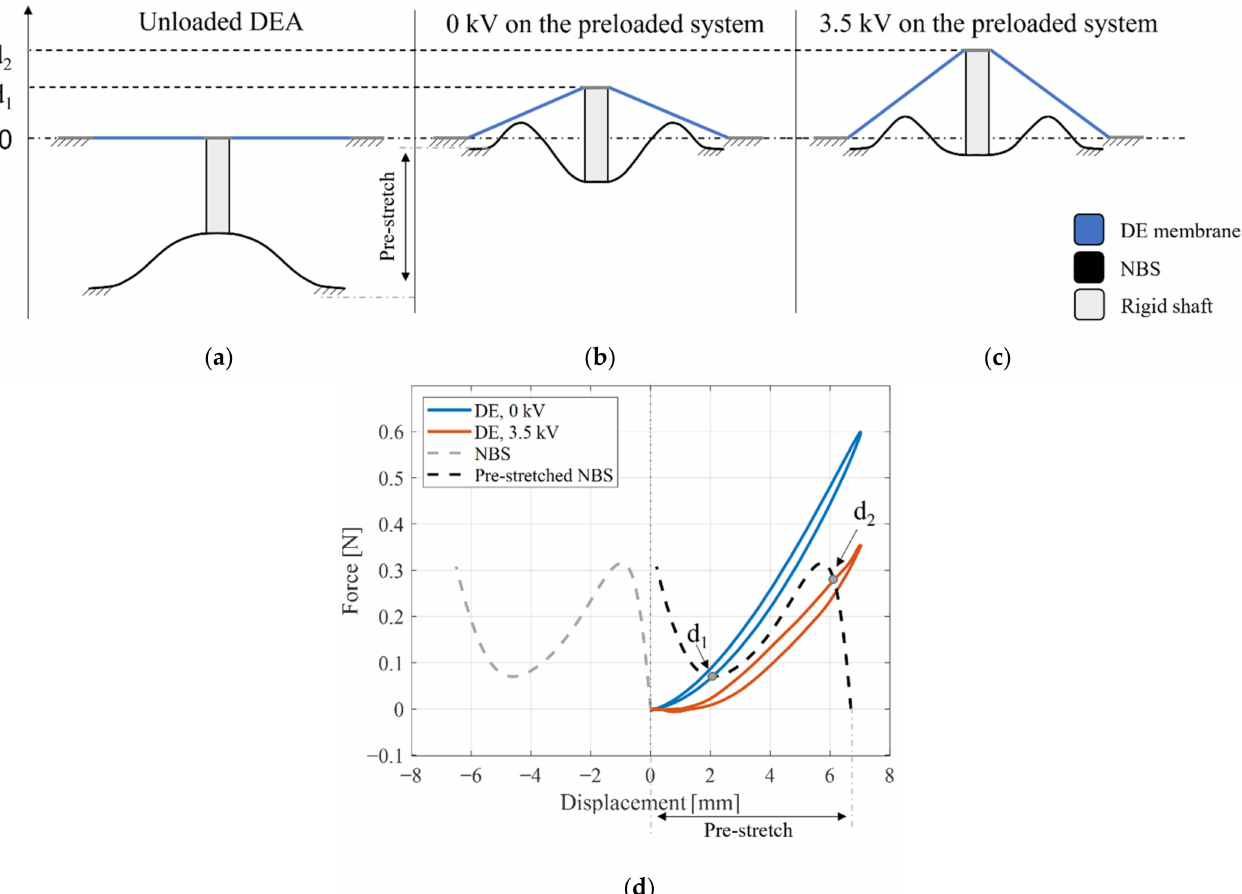
Figure 5. ( a – c ) Sketch of the DEA actuator composed by a DE membrane coupled with a NBS element, for three different configurations. ( d ) Actuator force equilibrium analysis, intersection points d 1 and d 2 represents the equilibrium states obtained by switching the